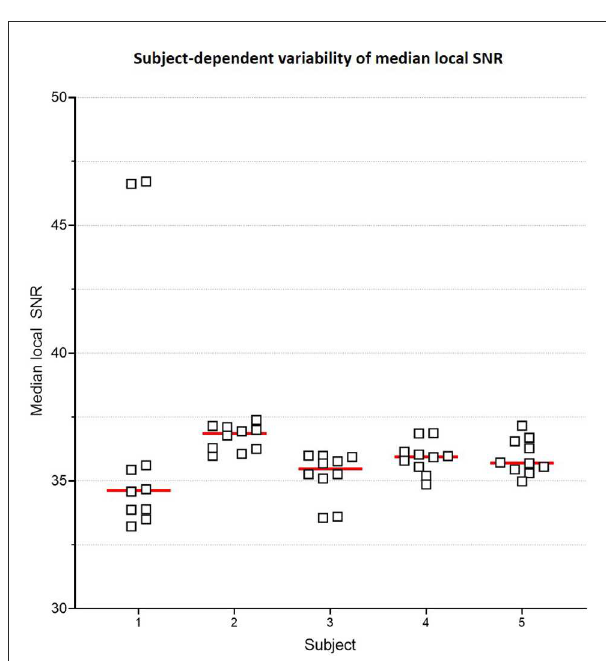
FIGURE6 Subject-specific median local SNR. Plot comparing median local SNR values for the two T 1 MPRAGE sequences from the Gold Standard protocol, across all 5 subjects and 5 repeats. This subject-dependent variability of SNR is the premise of subject-specific denoising in this